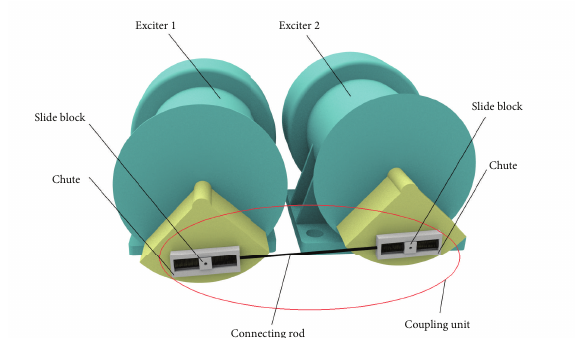
Figure 1: The model of the coupling